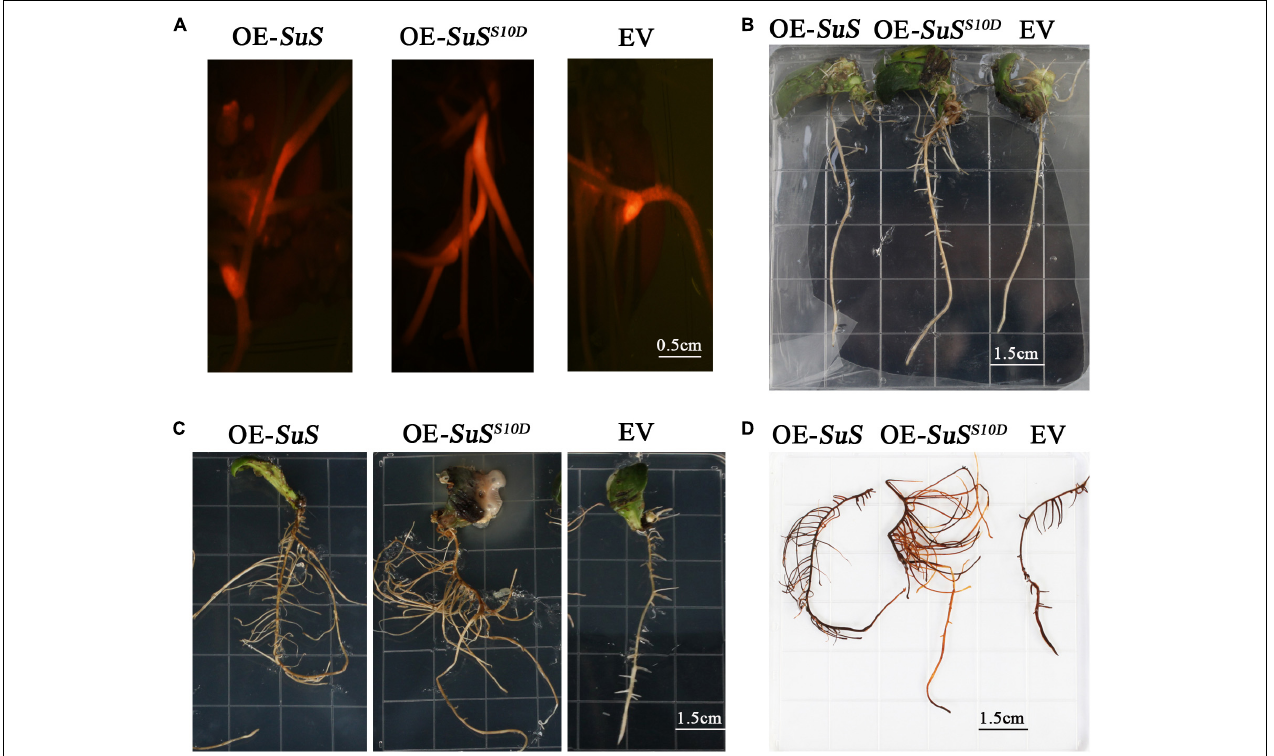
FIGURE 7 | Effects of salt treatment on transgenic roots of soybean plants. (A) Identified transgenic roots with red fluorescence, OE-SuS: SuS over-expressing lines, OE- SuS S 10 D : over-expressing lines of SuS S 10 D , and EV: empty vector lines. (B) The phenotypes of the transgenic roots of OE-SuS, OE- SuS S 10 D and EV before